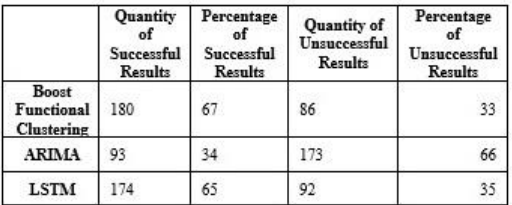
Table 4: 2019 USD/TRY Application Test Results